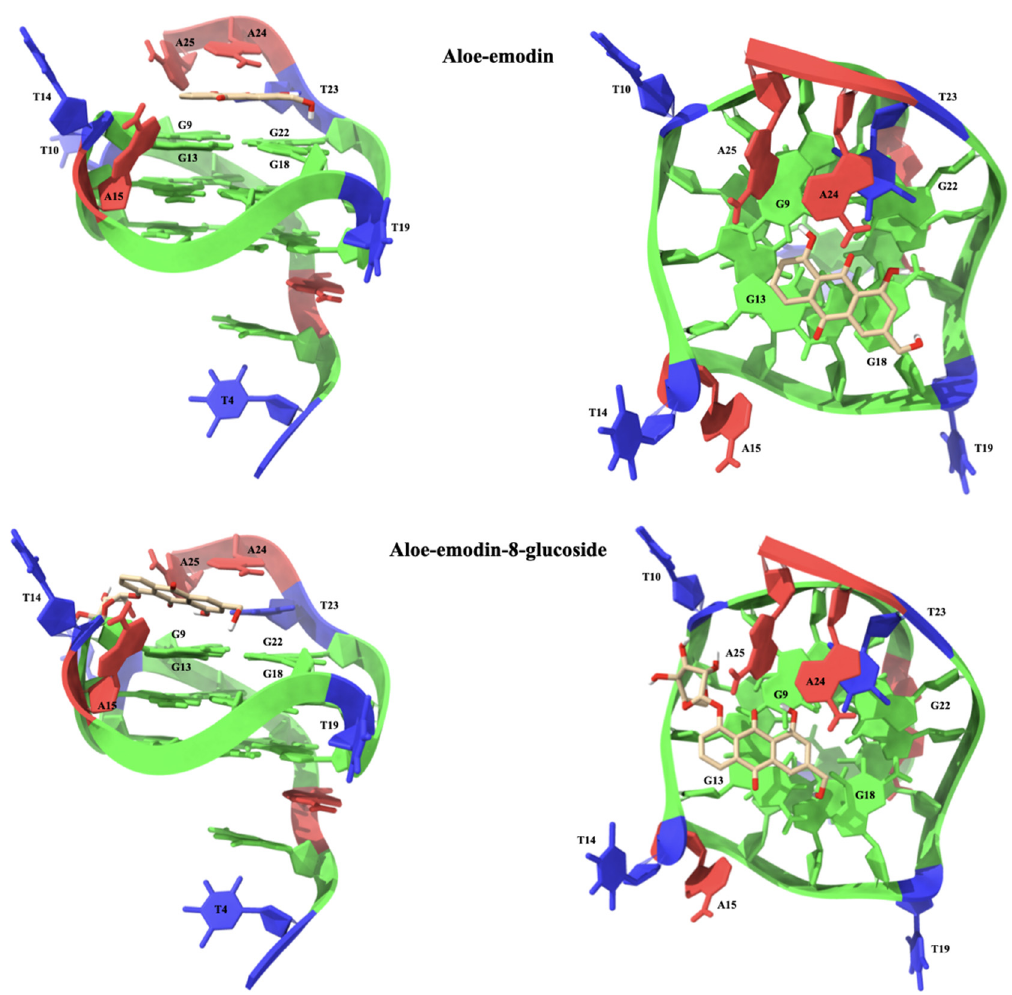
Figure 9. Lateral ( left ) and top ( right ) views of the aloe emodin ( 1 ) and aloe emodin-8-glucoside ( 2 ) complexes with the c-Myc G-quadruplex sequence. The nucleotides are shown as slabs and filled sugars: adenine in red, cytosine in yellow, guanine in green, and thymine in blue. Labels are added to highlight key nucleotides. The ligand molecules are rendered in sticks and colored according to the atoms and only polar hydrogens are shown.